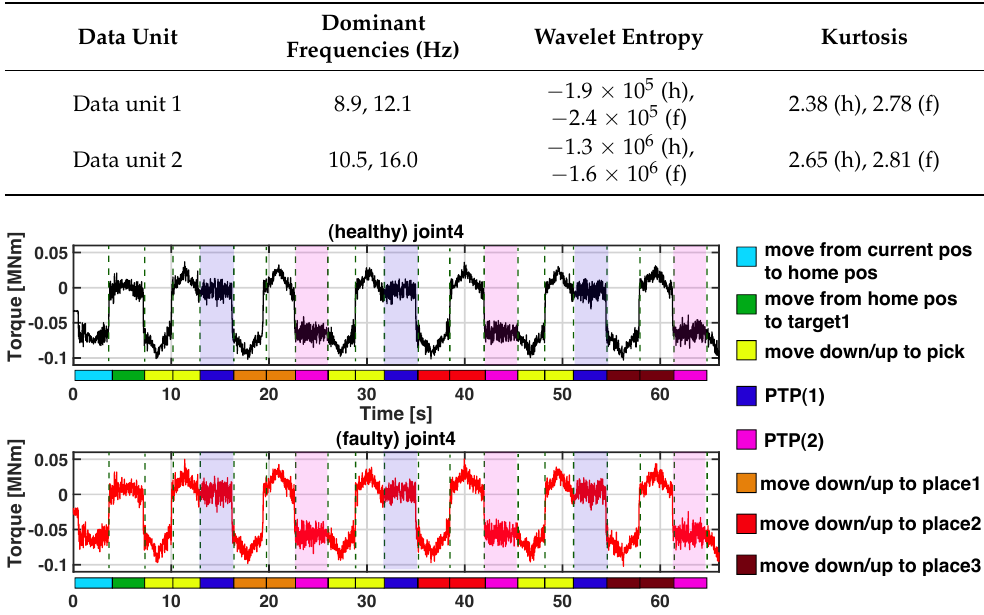
Table 2. HIs calculated after data unit extraction on signals represented in Figures 13 and 14. The values refer to data unit 1 and data unit 2 extractions in case of healthy (h) and faulty (f) conditions.